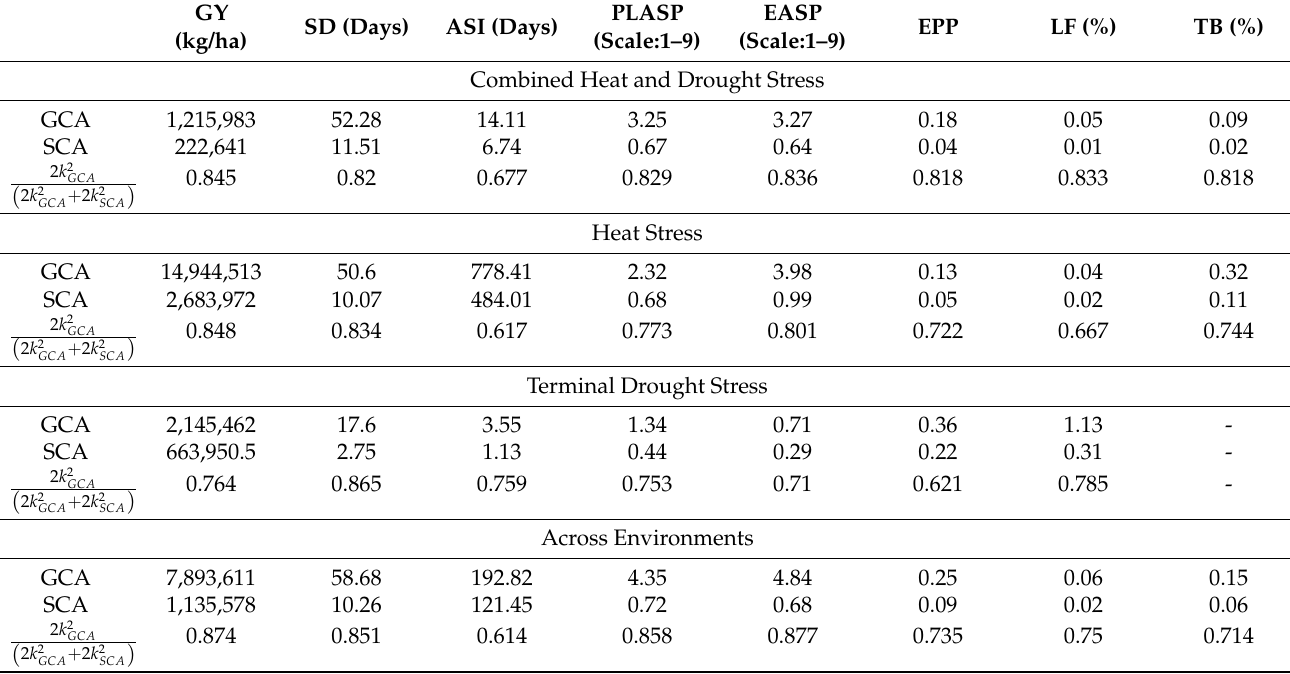
Figure 1. Proportion of GCA (lower bar) and SCA (upper bar) genetic variances for grain yield and other agronomic traits of tropical maize inbred lines under combined heat and drought, heat stress, terminal drought and across test environments. YIELD = Grain yield; SD= days to 50% silking; AD = days to 50% anthesis; ASI = anthesis-silking interval; PLHT = plant height; EHT = ear height; PASP = plant aspect; EPP = ears per plant; EASP = ear aspect; LD = leaf death; LF = leaf firing. Table 3. Prediction of hybrid performance based on parental GCA values as measured by the ratio of + 2 k 2 2 k 2 to 2 k 2 GCA GCA SCA